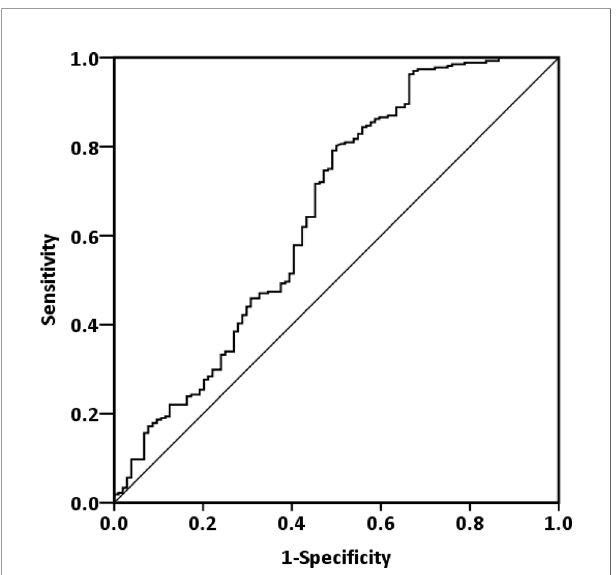
FIGURE 1 | ROC curve of ALI of patients with operable